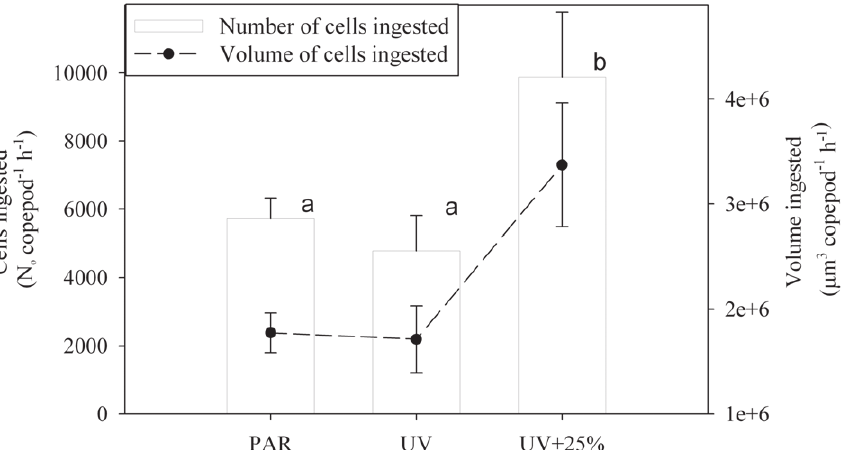
Figure 2. The number of cells (left axis) and volume of cells ingested by Calanusfinmarchicus feeding on Thalassiosiraweissflogii . Algae were cultured under one of 3 different light treatments: PAR only (PAR; Treatment 1), PAR plus ambient UVR (UV; Treatment 2), or PAR plus enhanced UVR (UV + ; Treatment 3). Grazing rates were measured over a 48 h feeding cycle. Ingestion rates were significantly higher in the UV + treatment. No significant difference was found in the grazing rates between the PAR- and ambient-UV-treated cells. Lower case letters indicate homogeneous groups after the ANOVA and post-hoc test (see methods for details).